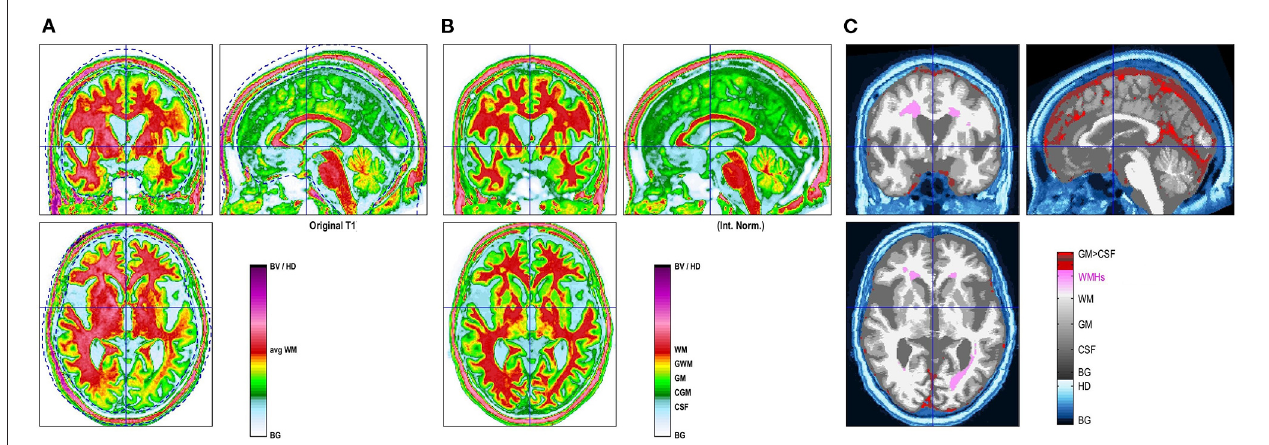
FIGURE 1 | CAT12 VBM images showing segmented brain tissues: original image (A) , normalized image with template (B) and WMH segmentation (C) .